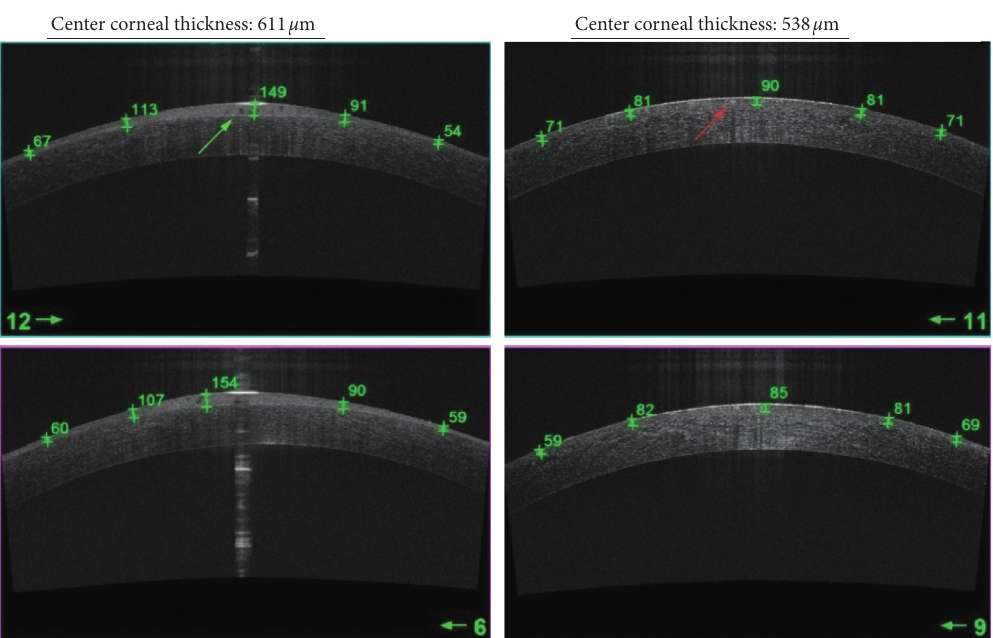
Figure 2: Comparison of representative SS OCTscans in the right and left eye. OD.SS OCTpachymetry map showing the increase of CCTto 611 μ m. High-resolution SS OCT cornea scan showing numerous hyporeflective small and oval cysts (green arrow) as well as increased thickness of the central corneal epithelium to 154 μ m. OS.SS OCTpachymetry map showing the CCTof 538 μ m. High-resolution SS OCT cornea scan showing few oval shaped, hyperreflective material within the central corneal epithelium (red arrow). Central epithelium thickness is increased to 90 μ